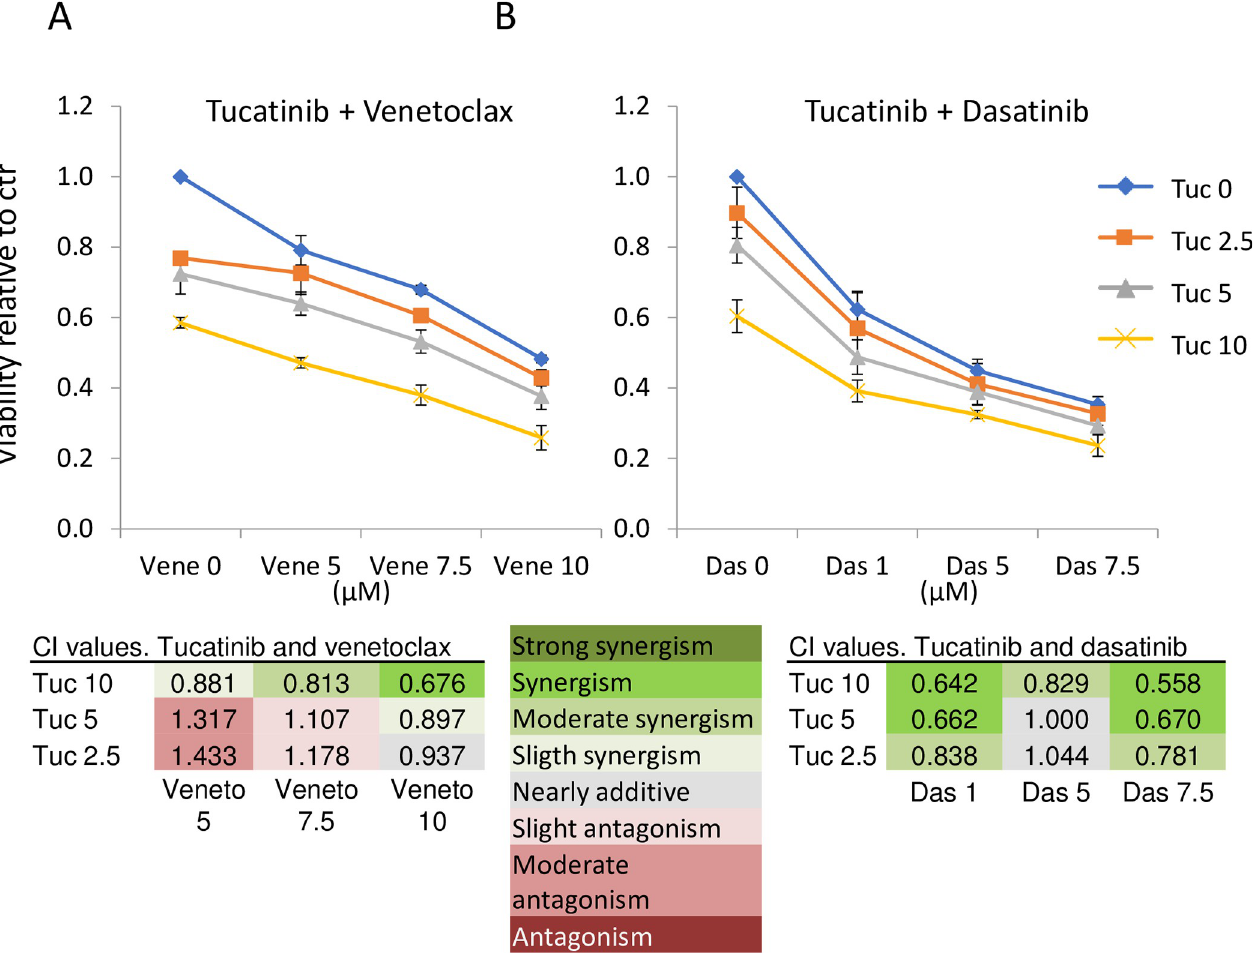
Fig 4. Synergy calculations after combinatorial treatment in KPL4 cells. The cells were treated with different doses of A) tucatinb (0, 2.5, 5, 10 μ M) and venetoclax (0,5, 7.5, 10 μ M), and B) tucatinib and dasatinib (0,1,5, 7.5 μ M) for 72 hours. Error bars represent standard deviation of three biological experiments. Viability values were uploaded to the CalcuSyn software, and combination index values (CI) suggests antagonism, additivity, or synergy. Das = dasatinib, Tuc = tucatinib, Vene = venetoclax.